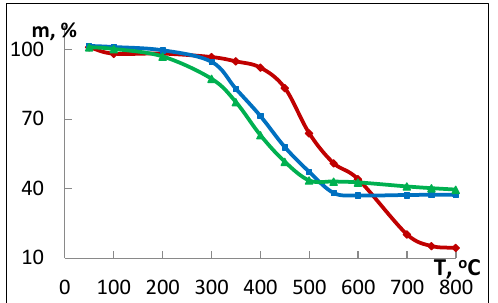
Figure 2. TGA curves of AFP (red color), AFP + Cu(NO 3 ) 2 (blue) and AFP + Co(NO 3 ) 2 (green).